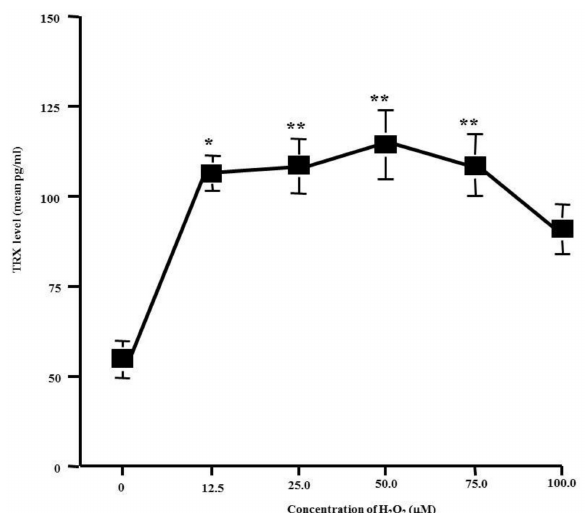
Figure 1. Influence of H 2 O 2 on thioredoxin (TRX) production from HNEpCs in vitro. Nasal epithelial cells (5 × 10 5 cells) were stimulated with various concentrations of H 2 O 2 . After 24 h, TRX levels in culture supernatants were examined with ELISA. The data are expressed as the mean pg/mL ± SE of triplicate cultures. One representative experiment of two is shown in this figure. *: P < 0.05 versus